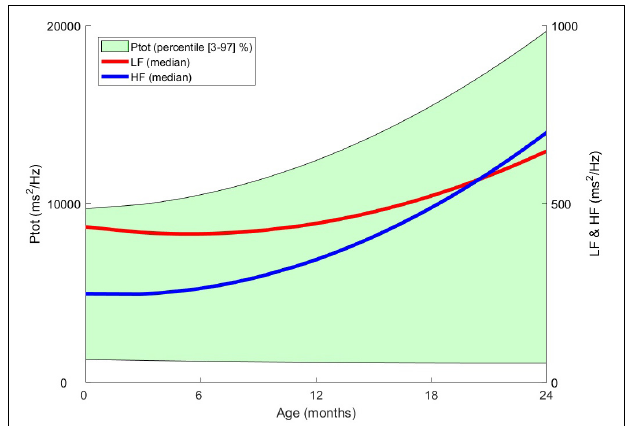
FIGURE 3 | From birth to the age of 2 years, evolution of heart rate variability indices in the frequency domain. Ptot: total power of the spectrum (ms2 / Hz), LF: low frequency (ms2 / Hz), HF: high frequency (ms2 / Hz) – Data from the AuBE